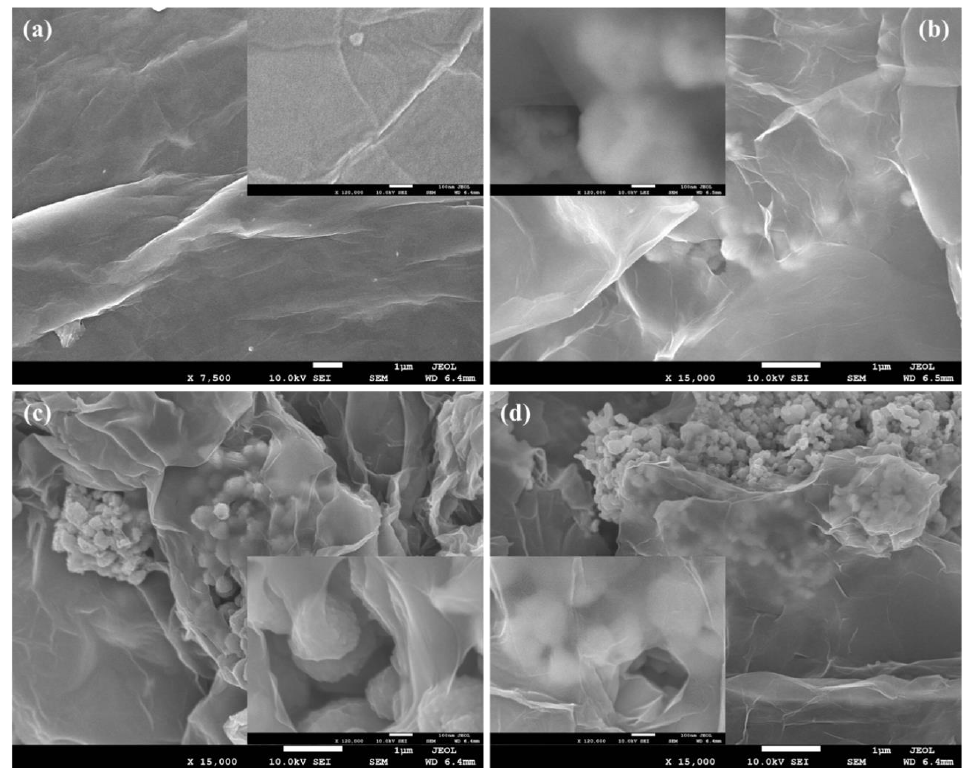
Figure 2. Low and high magnification (insets) FESEM images of ( a ) GN; ( b ) GN@Cu; ( c ) GN@CR; and ( d ) GN@CR-Cu.